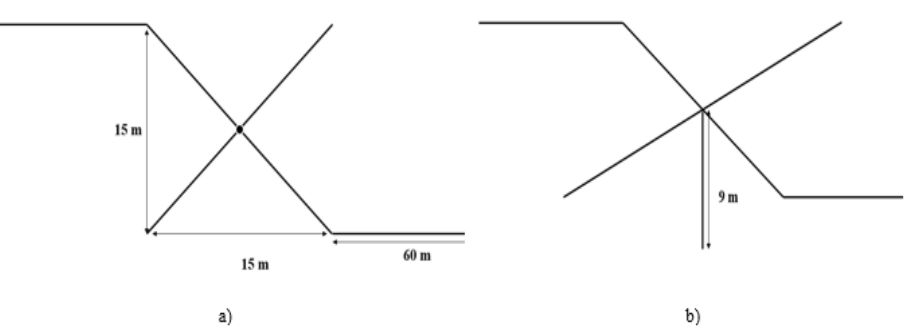
Figure 4. Design A: Default design with counterpoise; ( a ) top view; ( b ) 3D view.